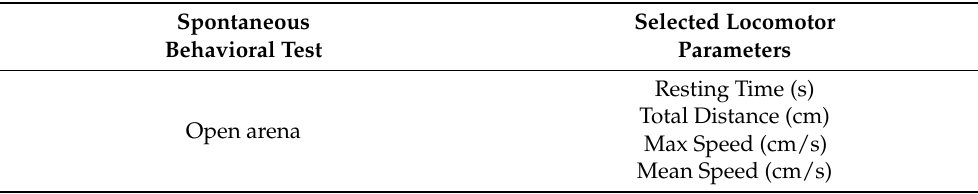
Table 1. Open arena test and chosen